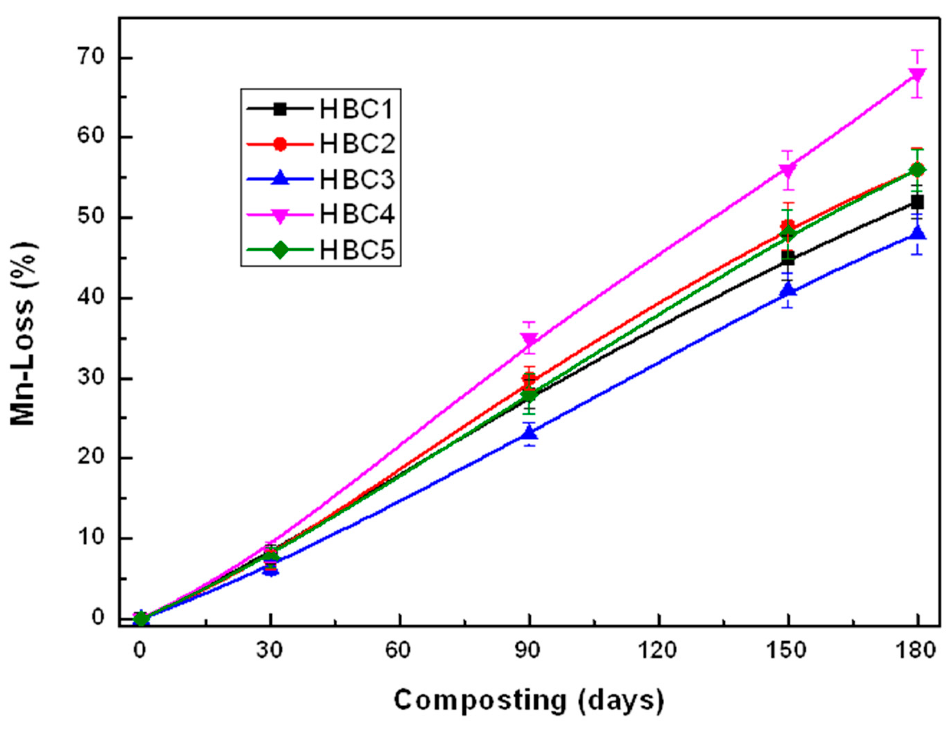
Figure 5. HBC molecular weight loss changes during composting.